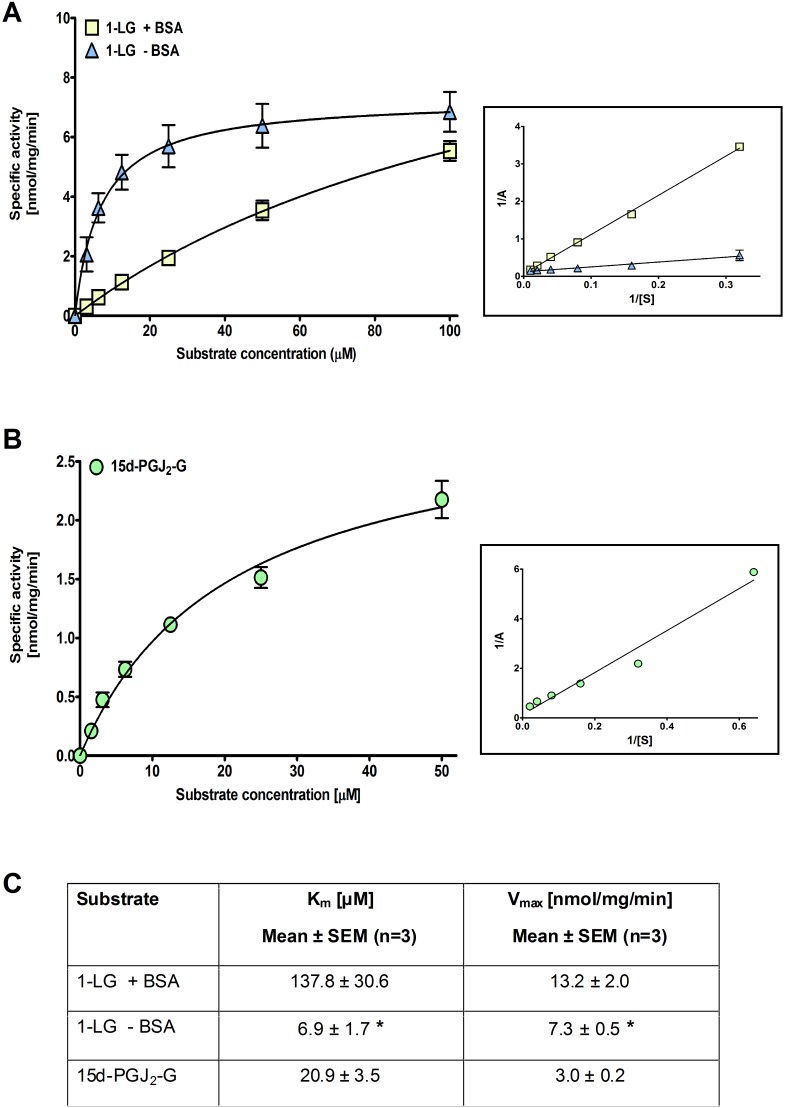
Km and Vmax values for hBAT5-dependent hydrolysis of 1-LG and 15d-PGJ2-G.HEK293 cells were transiently transfected with the cDNA encoding hBAT5, as detailed in the Methods section. After 48 h, cells were harvested and lysates prepared for hydrolase activity measurements. Cellular lysates (0.3 µg/well) were incubated together with the indicated concentrations of 1-LG in assay mixes containing (+ BSA) or not (– BSA) 0.5% (w/v) BSA (A) or with 15d-PGJ2-G in assay mix containing BSA (B). The Km and Vmax values (C) were determined at time-point 90 min, where substrate utilization was <10%, and were calculated as non-linear regressions using GraphPad Prism 5.0 for Windows. As crude cellular lysates were used, total protein concentration was used instead of true enzyme concentration. The Lineweaver-Burk plots are shown inside rectangles. Statistical comparison of the Km and Vmax values for 1-LG between the + and - BSA conditions was done using unpaired t-test and the significance is indicated with an asterix (*, p<0.05). Values are mean ± SEM from three independent experiments.